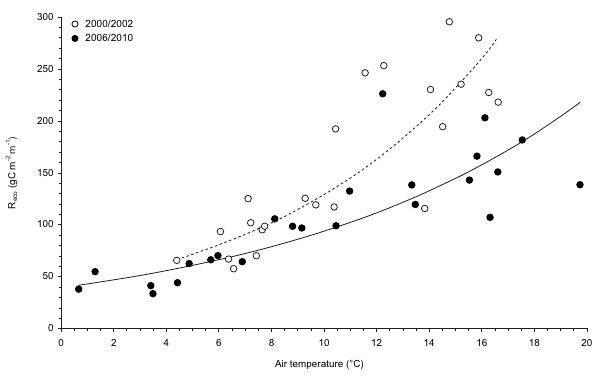
Fig. 10. Relationship between the monthly sum of R eco and mean monthly air temperature for years of high (2000 and 2002; r 2 = 0.75) and low (2006 and 2010; r 2 = 0.78) annual R eco